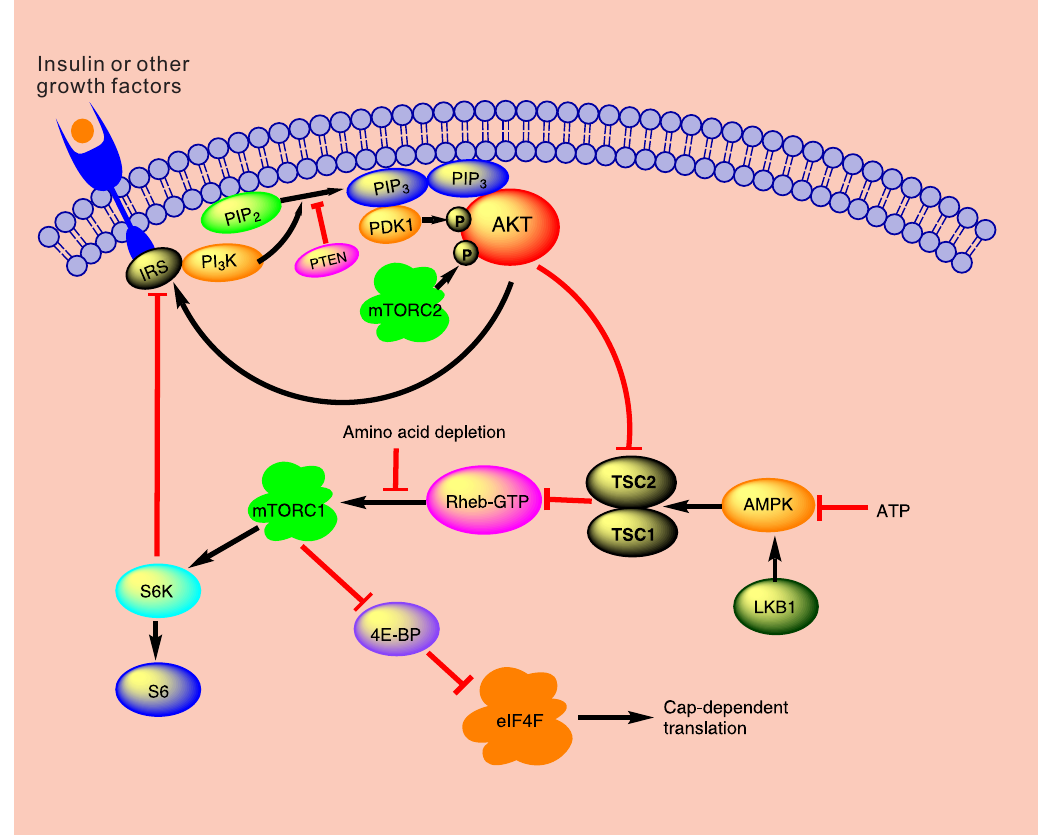
Figure 1. The PI3K/Akt/mTOR pathway. Upon insulin stimulation, the insulin receptor phosphorylates IRS at tyrosine sites, which, in turn, activates PI3K. PI3K then converts PIP2 into PIP3. PIP3 recruits Akt to the membrane, where Akt is phosphorylated by the enzymes PDK1 and mTORC2. Note the two fedback loops: one is the positive feedback from pAkt directly to IRS; the other is the negative feedback from pAkt through mTORC1 to